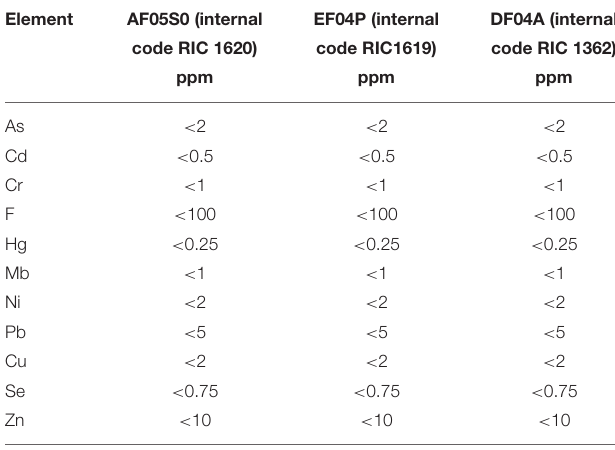
TABLE 4 | Concentration of regulated metals in Mater-Bi materials.